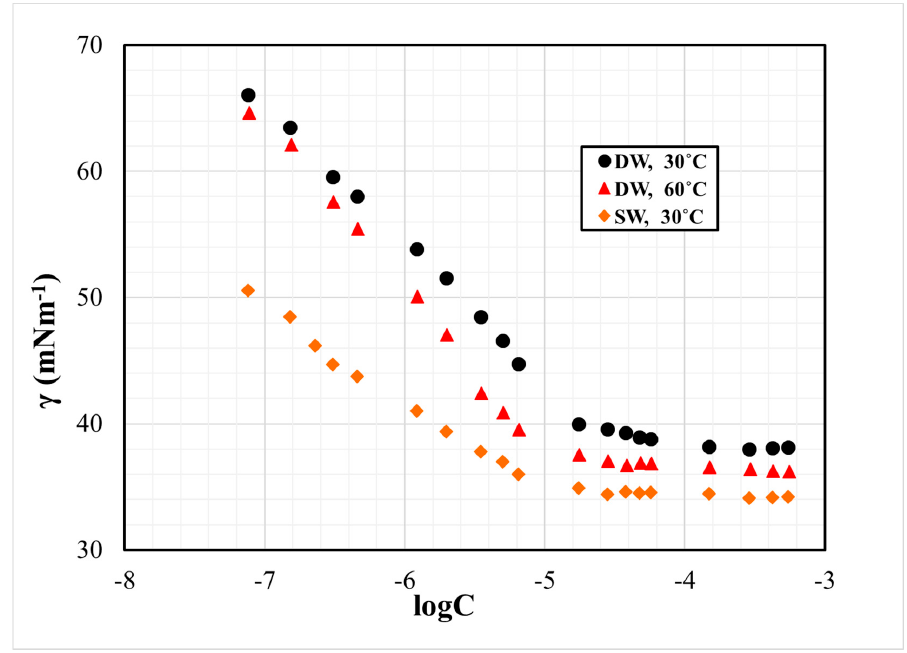
Figure 13. The surface tension of GS10 at different salinities and temperatures.